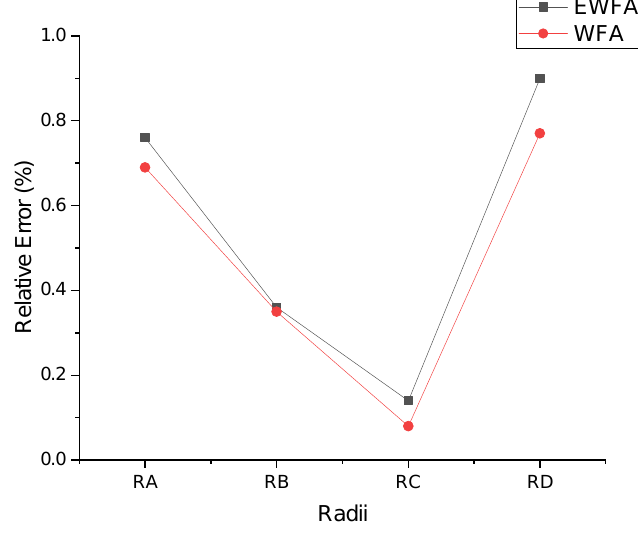
Figure 9. The error of radii in the first